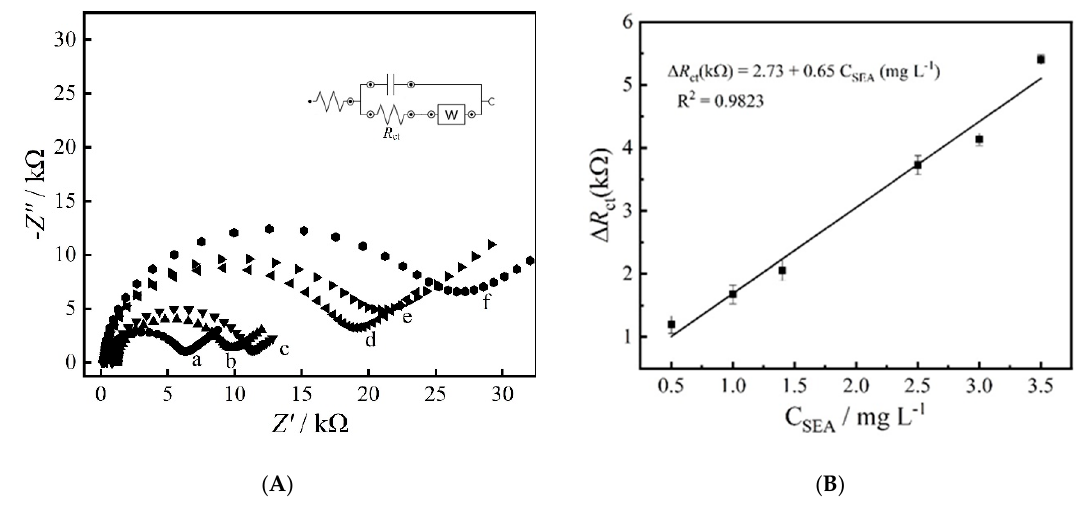
Figure 6. Nyquist plots of the immunosensor incubated with different SEA concentrations ( A ) and respective calibration curve from 0.5 to 3.5 mg L − 1 ( B ).